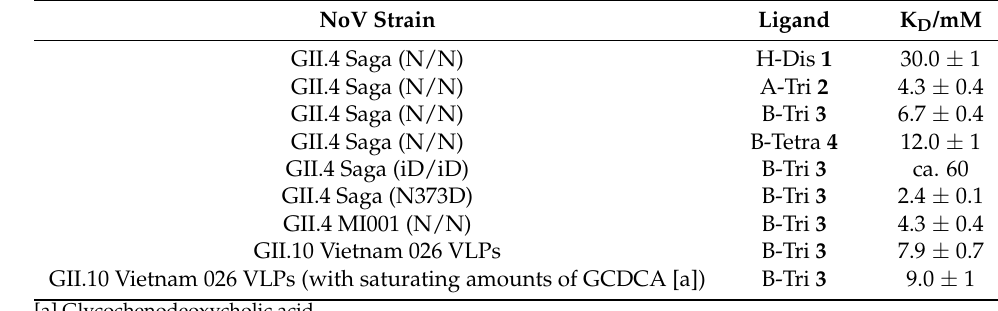
Table 1. Dissociation constants K D for binding of HBGAs to NoV P-domains and VLPs. Rows 1 to 7: K D values from CSP NMR titrations of P-dimers (cf. Figure 1 for corresponding titration curves; the titration curve for A-Tri 2 is found in the supporting information. Figure S6). NMR samples were prepared in 75 mM sodium phosphate, 100 mM NaCl (pH 7.3). Protein concentrations were 230–300 µ M for Saga N/N P-domains, 210 µ M for Saga iD/iD P-domains, 240 µ M for Saga N373D, and 220 µ M for MI001. Rows 8 and 9: K D values from STD NMR experiments acquired at 277 K for